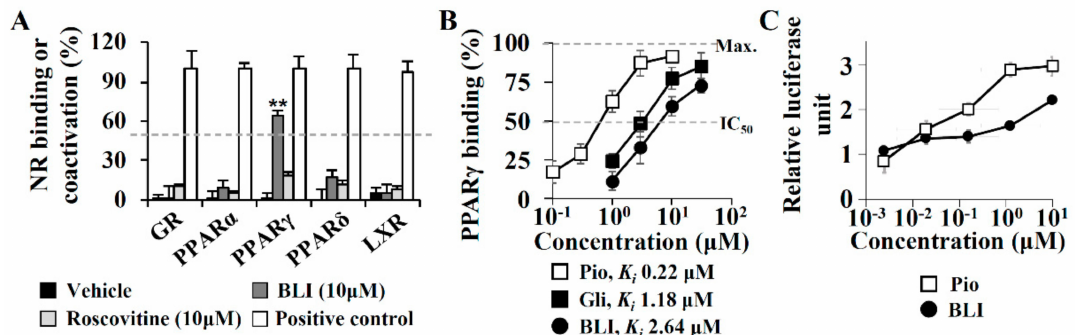
Figure 3. Molecular target identification of butyrolactone I. ( A ) Competitive time-resolved fluorescence resonance energy transfer (TR-FRET)-based nuclear receptor (glucocorticoid receptor (GR), PPAR subtype α / γ / δ , and iver X receptor (LXR)) binding assay was performed for butyrolactone I and roscovitine. ( B ) Ki values for PPAR γ binding were calculated by the Cheng and Pruso ff equation. Pioglitazone (pio) and glibenclamide (gli) were used as positive controls. ( C ) Cell-based PPAR γ luciferase reporter transactivation assay was performed. HEK293T cell was co-transfected with an expression vector encoding full length PPAR γ , a reporter vector encoding the firefly luciferase following PPAR γ response element (PPRE), and a normalization vector encoding the Renila luciferase. After the treatment of the compounds including the butyrolactone I for 20 h to the cells, the signals of luminescence were detected and normalized. Values represent means ± SD ( n = 3); * p ≤ 0.05, ** p ≤ 0.01. IC 50 : half-maximum inhibition